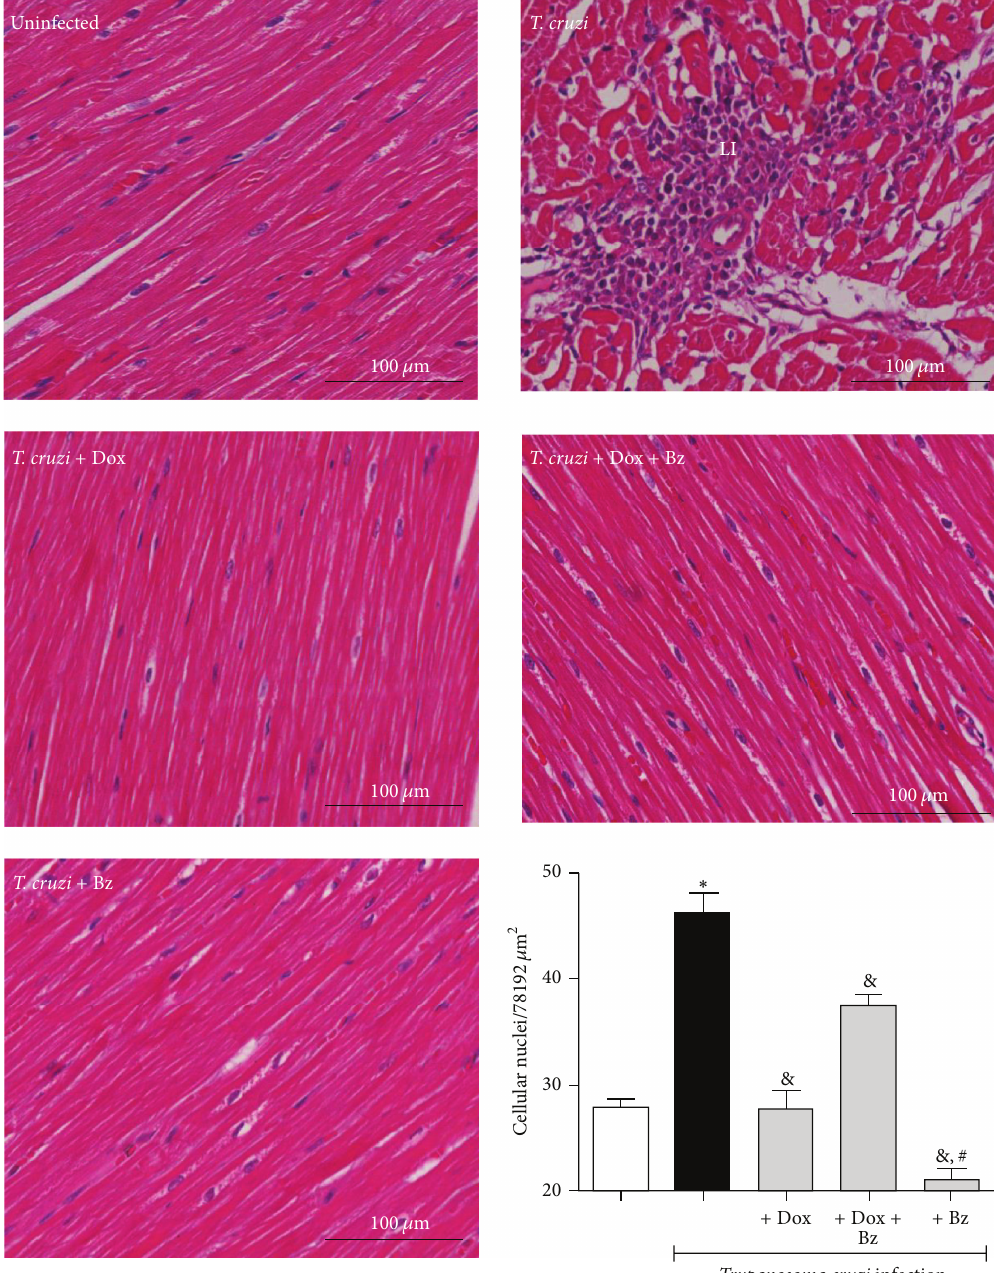
Figure 6: Benznidazole and doxycycline reduce inflammation in the T. cruzi -infected left ventricle. Mongrel dogs infected with T. cruzi and treated with doxycycline (Dox), with benznidazole (Bz), or with the association of Dox + Bz had their heart extracted in the chronic phase to evaluate the inflammatory infiltration (H&E) in the left ventricle segment. The noninfected group was evaluated in parallel and sections were quantified in sections with 40x of magnification. Data are representative of the groups ( 𝑛 = 5 animals) and ∗ 𝑝 < 0.05 in relation to the noninfected group; & 𝑝 < 0.05 in relation to the infected group without treatment; # means difference ( 𝑝 < 0.05 ) in relation to the Dox and Dox + Bz. LI: leukocytes